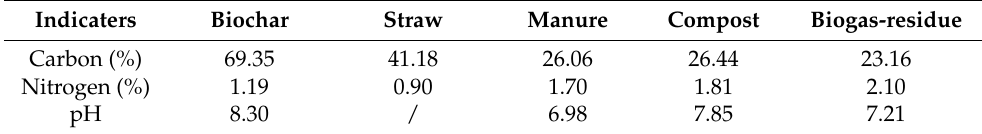
Table 1. Carbon and nitrogen content and pH value of different organic